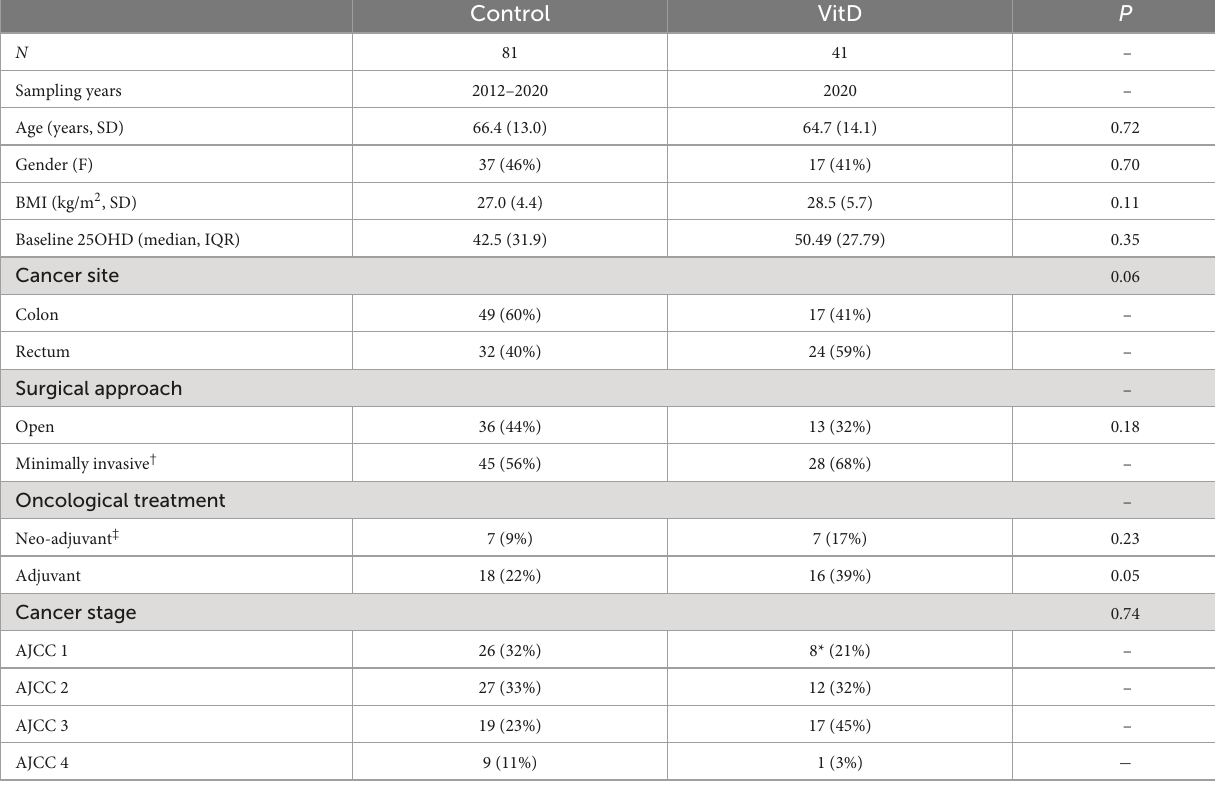
TABLE 1 Clinicopathological demographics of included